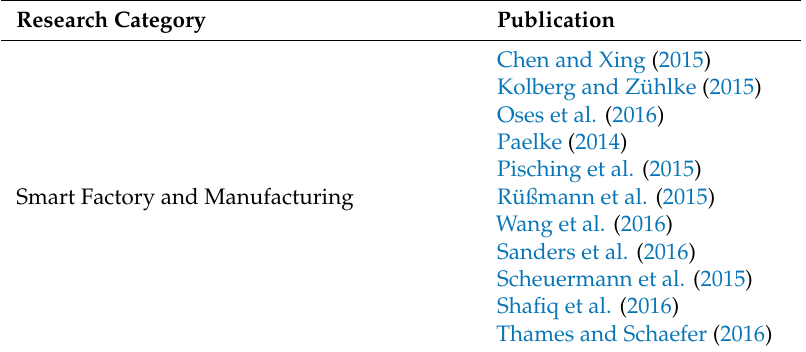
Table 1. Studies on Smart Factory and